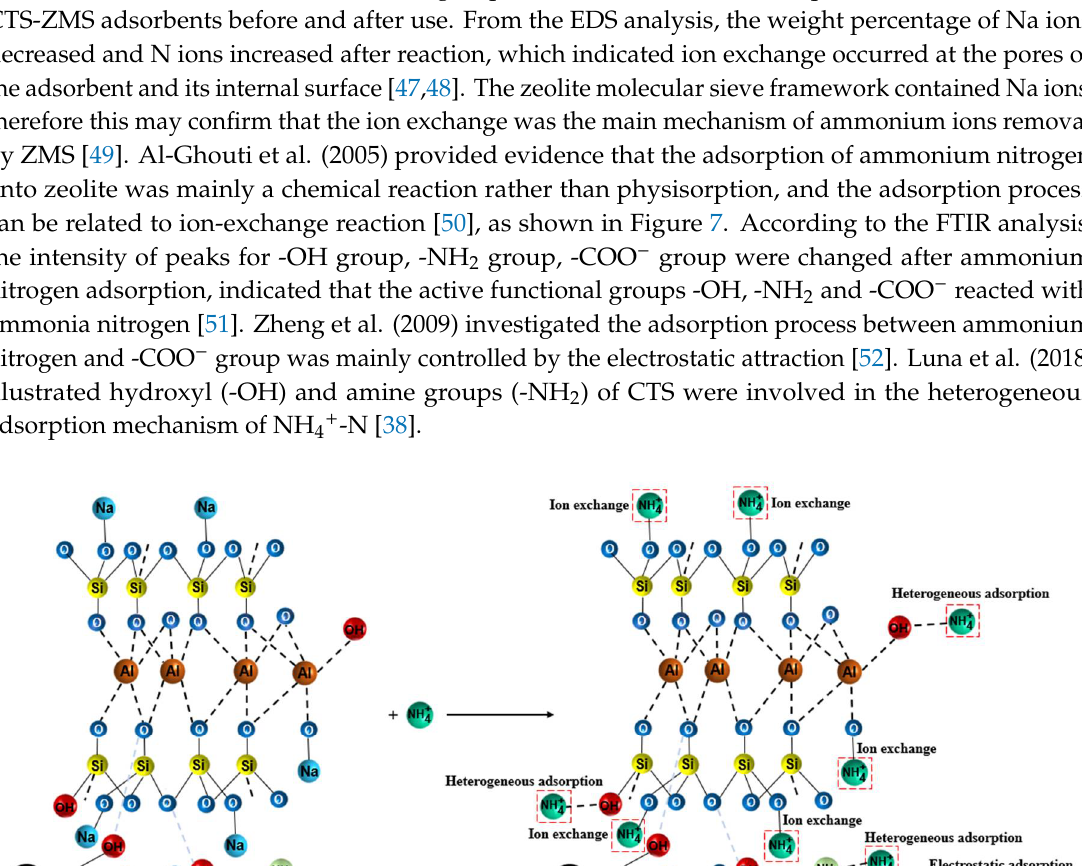
Figure 6. FTIR spectra of the CTS-ZMS samples before and after ammonium nitrogen adsorption.